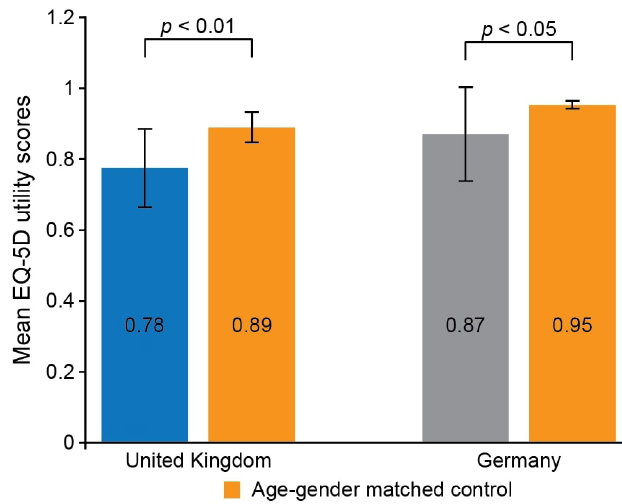
Figure 1. HRQoL measured using the EQ-5D-5L questionnaire cross-walk into EQ-5D-3L in caregivers in the United Kingdom and Germany compared with age/gender-matched controls [31]. A score of 1 indicates “perfect health”, a score of 0 indicates “death” (includes adult siblings). EQ-5D-3L, EuroQoL five-dimension, three- level questionnaire; EQ-5D-5L, EuroQoL five-dimension, five-level questionnaire; HRQoL, health related quality of